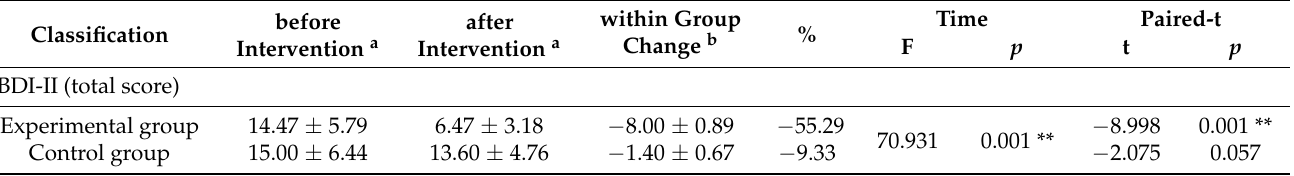
Table 9. Changes in depression before and after intervention on two intervention groups.